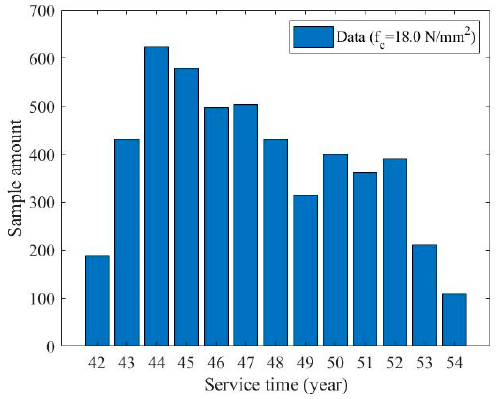
Figure 2. Statistics of concrete strength ( f c = 18.0N/mm 2 ).